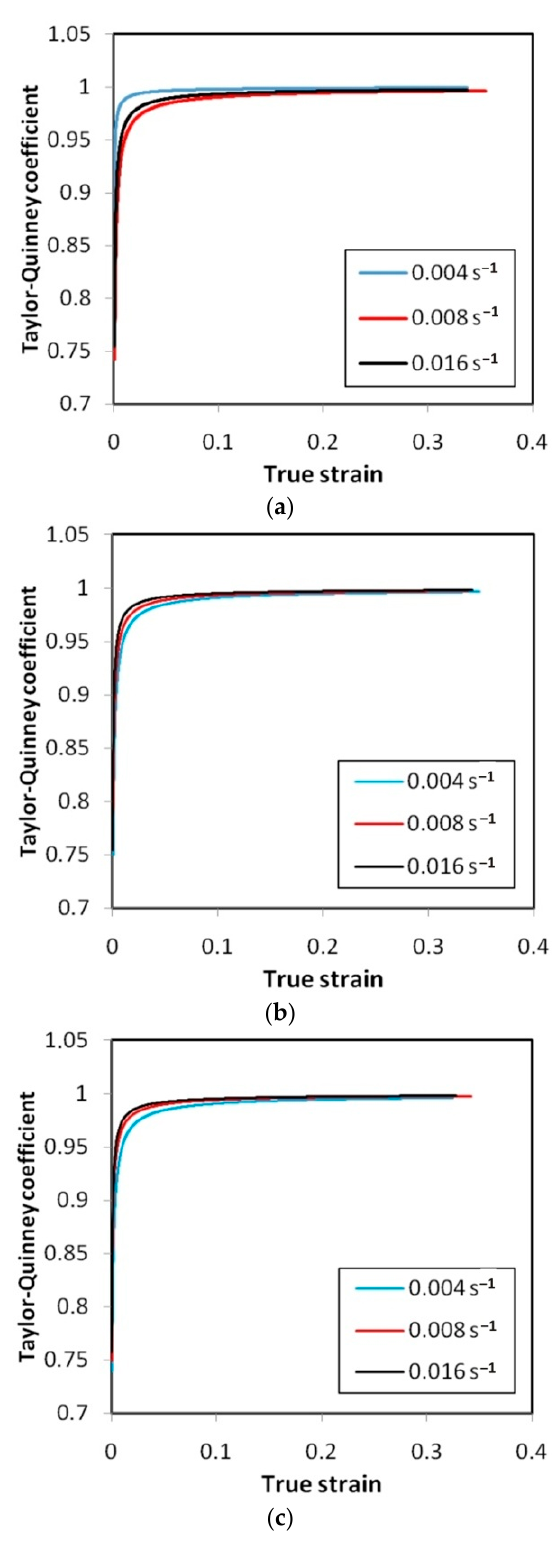
Figure 23. Variation of the Taylor–Quinney coefficient vs. true strain for I625 specimens oriented at: ( a ) 0°, ( b ) 45° and ( c ) 90°.